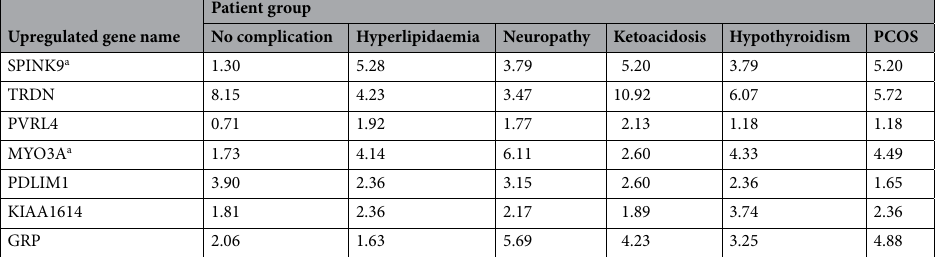
Table 4. Relative fold changes of upregulated genes in different patients’ groups with T1DM complications compared to healthy control group. a Indicates significant increases in the expression of the upregulated genes in different T1DM complications compared to no complications. PCOS Polycystic Ovarian